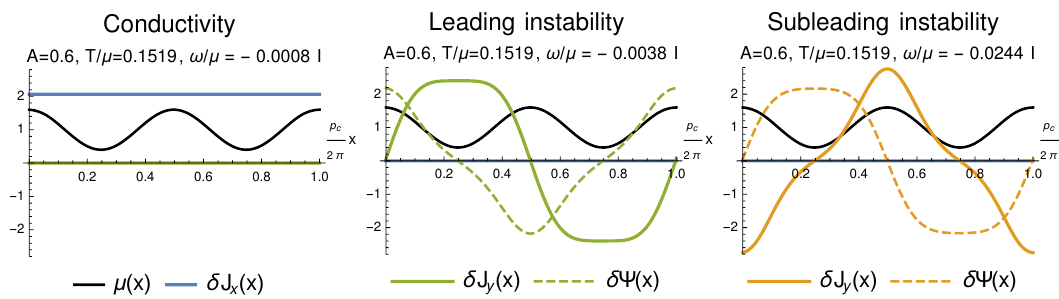
Figure 4. The profiles of the observables, corresponding to the quasinormal modes in the normal phase of holographic model with periodic spontaneous structure. The modes are those marked with darker markers on the left panel of figure 3. The black line shows the profile of explicit modulation of the background chemical potential (3.3). The conductivity mode (blue) is homogeneous and is sourced by a constant electric field E modes are triggered by the spatially oscillating sources δψ (yellow). The observables are the transverse current J Ψ , dual to field ψ (dashed). Note the close similarity to the right panel of figure